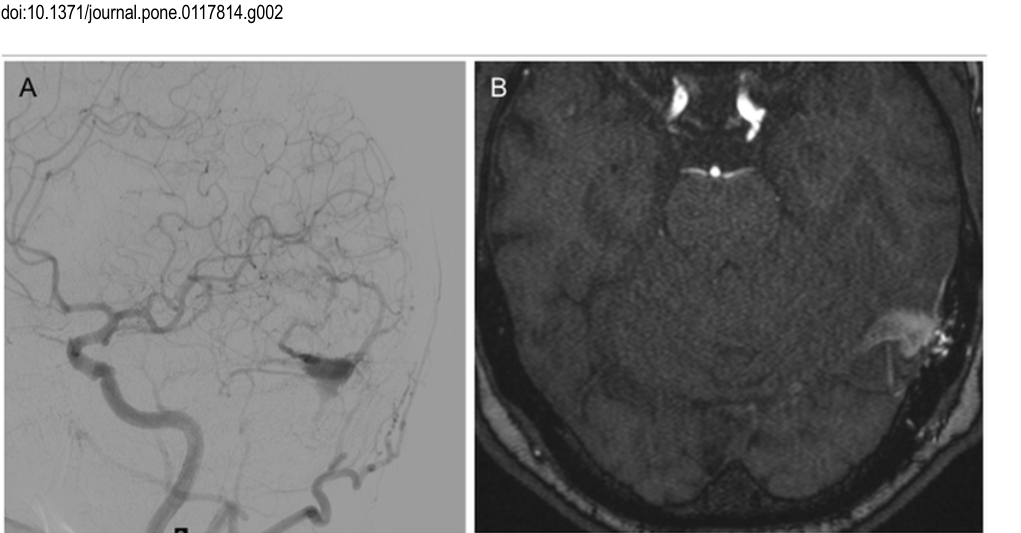
Fig 3. 64 year old male patient with PT on the left ear since 4 months. DSA of the left carotid artery shows a left sided dAVF Type III Cognard/Merland classification (A). The venous drainage leads direct into a trapped left sided transverse sinus into a cortical vein, which is not dilatated (B).